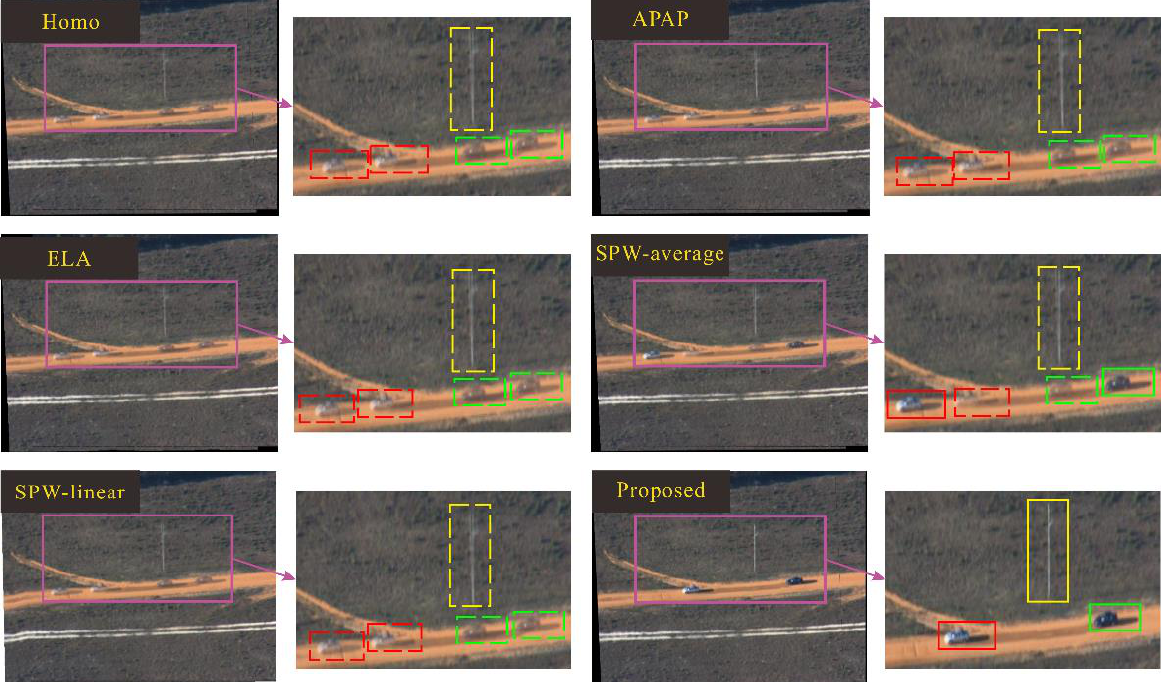
Figure 10. The effectiveness of the mesh-based ghost identification method.